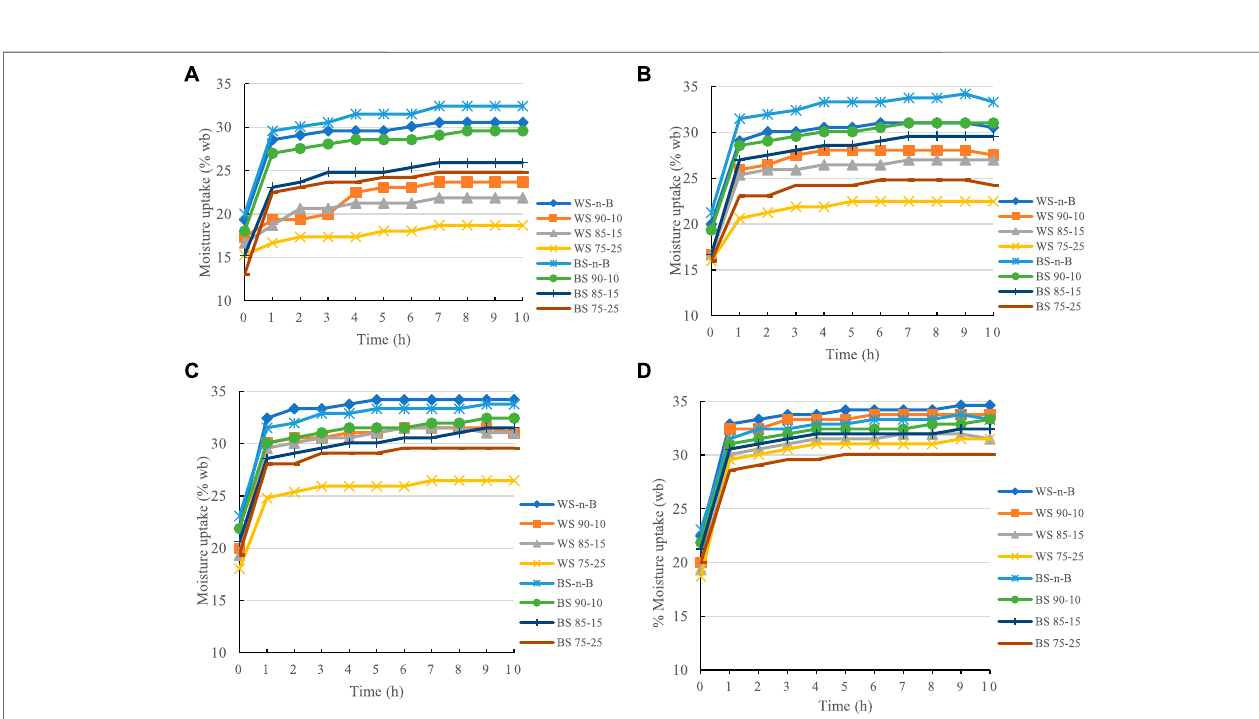
FIGURE 7| Moisture adsorption ofpellets made of MW-torre fi ed (wheat straw biochar and barley straw biochar) at 8% moisture content for different HDPE binder levels (A) 6%; (B) 10%; (C) 20%, and (D) 25% at 6 ° C and 95% RH.